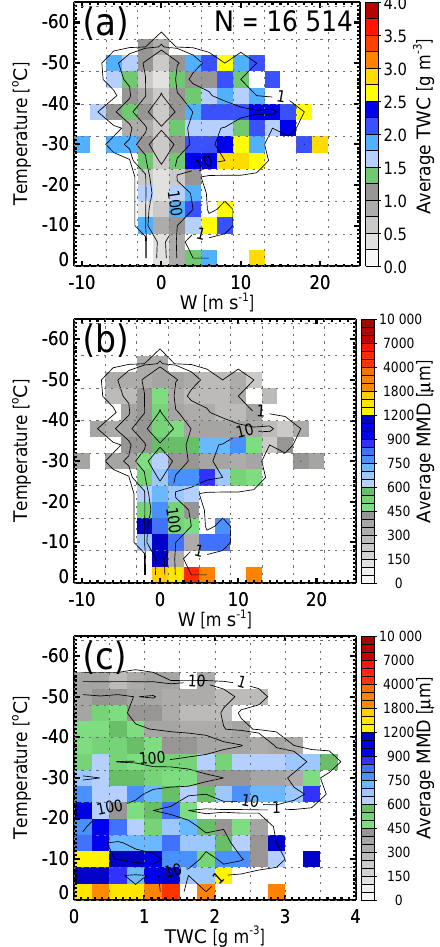
Figure 6. Observed joint histograms using Darwin HAIC-HIWC data: (a) w – T bins color-filled with average TWC, (b) w – T bins color-filled with average MMD, and (c) TWC– T bins color-filled with average MMD. Observational sample size is shown in the top right corner and order of magnitude sample sizes are contoured in black. Bin sizes are 2ms − 1 for w , 0.25gm − 3 for TWC, and 4 ◦ C for temperature. Note that the average MMD color scale is nonlinear and accentuates variability for average MMDs <